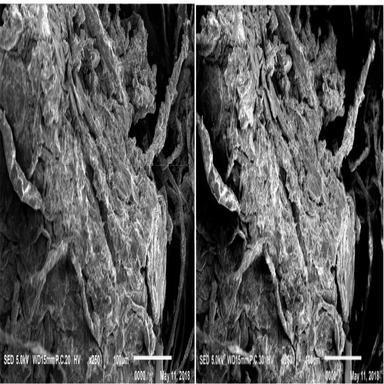
SEM images of the DMPI + HP-β-CyD inclusion complex.